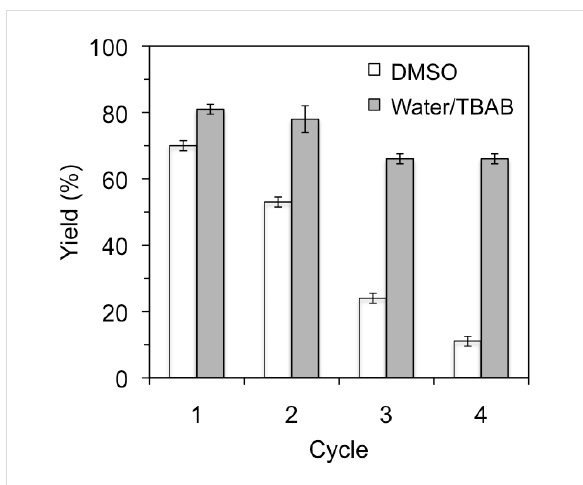
Figure 1: Typical recycling experiments for the gelatin-catalyzed Henry reaction. Reaction conditions: 4-Nitrobenzaldehyde ( 1a ,